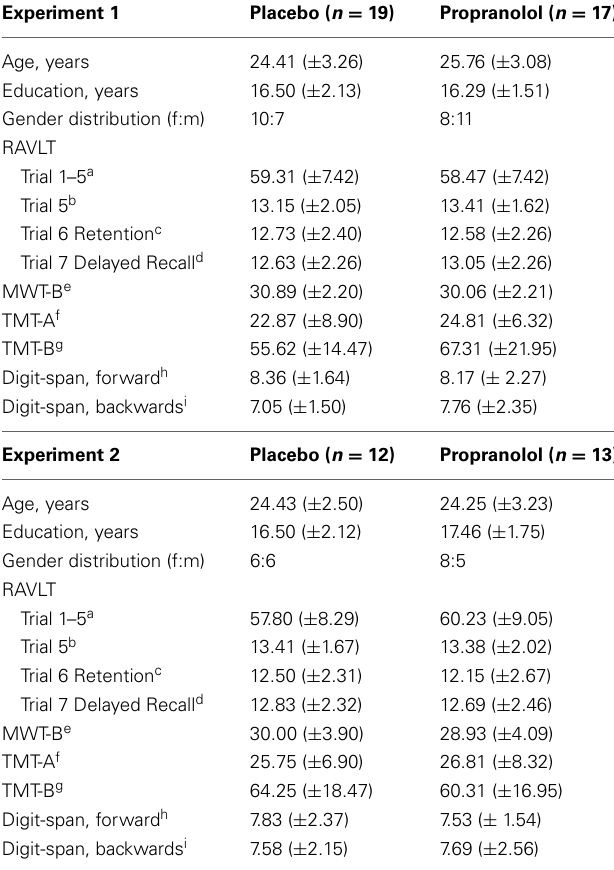
Table 1 | Two-sample t -tests showed no significant pretreatment differences in demographic and neuropsychological characteristics between the placebo- and propranolol-treated groups (displayed are mean and SD for both